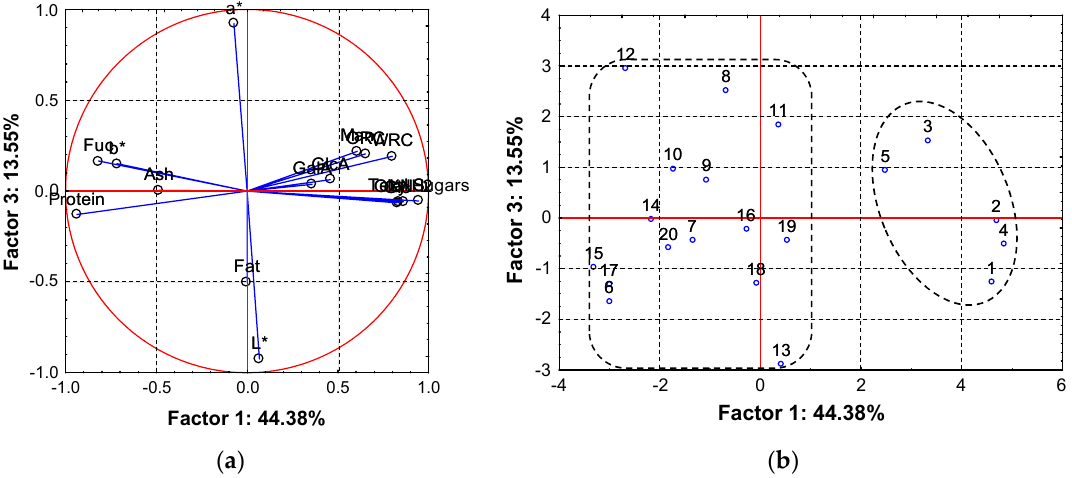
Figure 6. ( a ) Factor loading plot based on correlations of the mushroom DFI chemical composition, color characteristics and functional properties projected on the space of PC1 vs. PC3; ( b ) scores plot of the mushroom DFI samples projected on the space of PC1 vs. PC3.